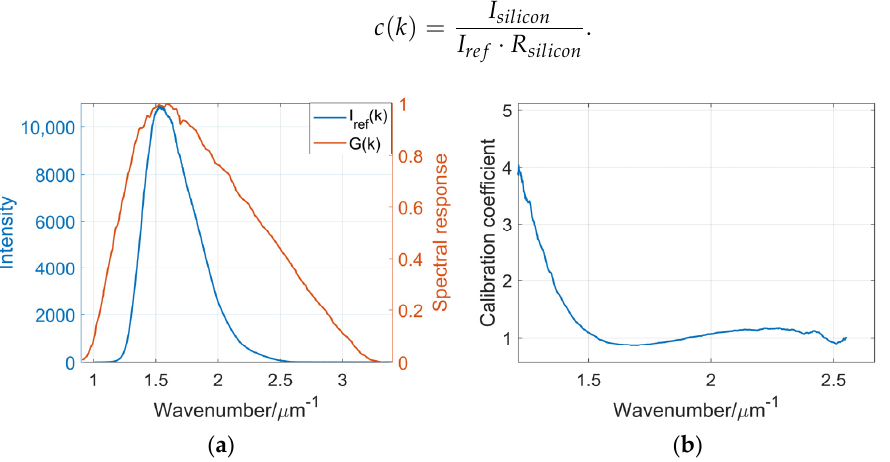
Figure 6. ( a ) Spectrum of the light reflected from the reference mirror (blue) and spectral response of the camera (orange). ( b ) Calibration coefficient.